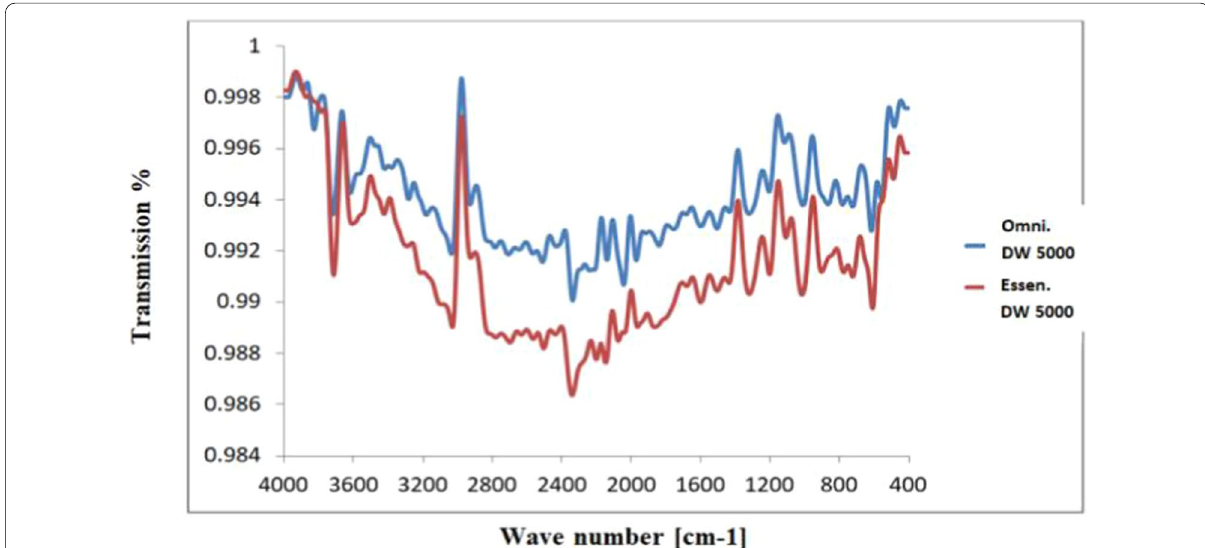
Fig. 7 FTIR spectra representing the chemical structure of Omnichroma DW 5000 and Essentia DW 5000